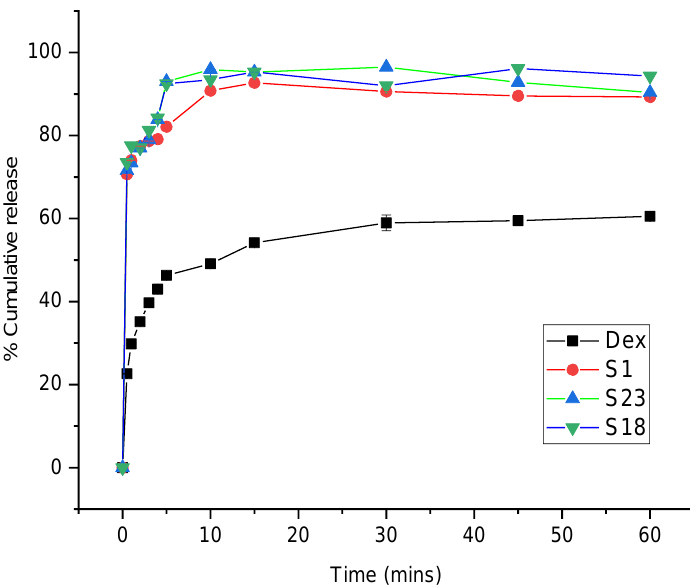
Figure 7. Dissolution profile of Dex and optimized formulations at pH 6.8. The error bar designates the standard deviation (n = 3).